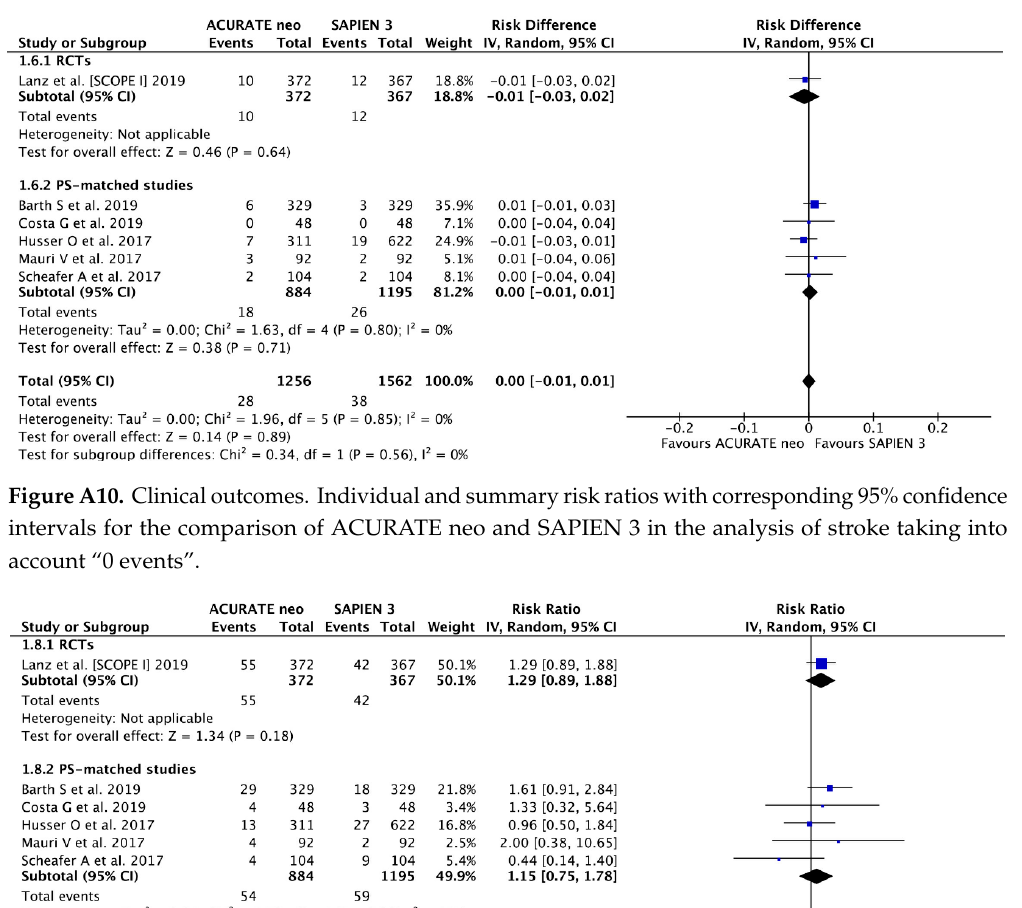
Figure A9. Clinical outcomes. Individual and summary risk ratios with corresponding 95% confidence intervals for the comparison of ACURATE neo and SAPIEN 3 in the analysis of stroke.